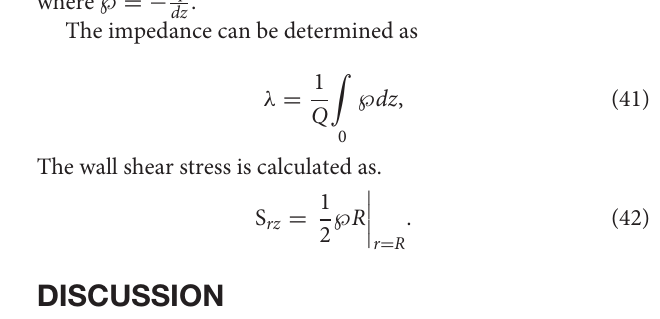
Frontiers in Physics |